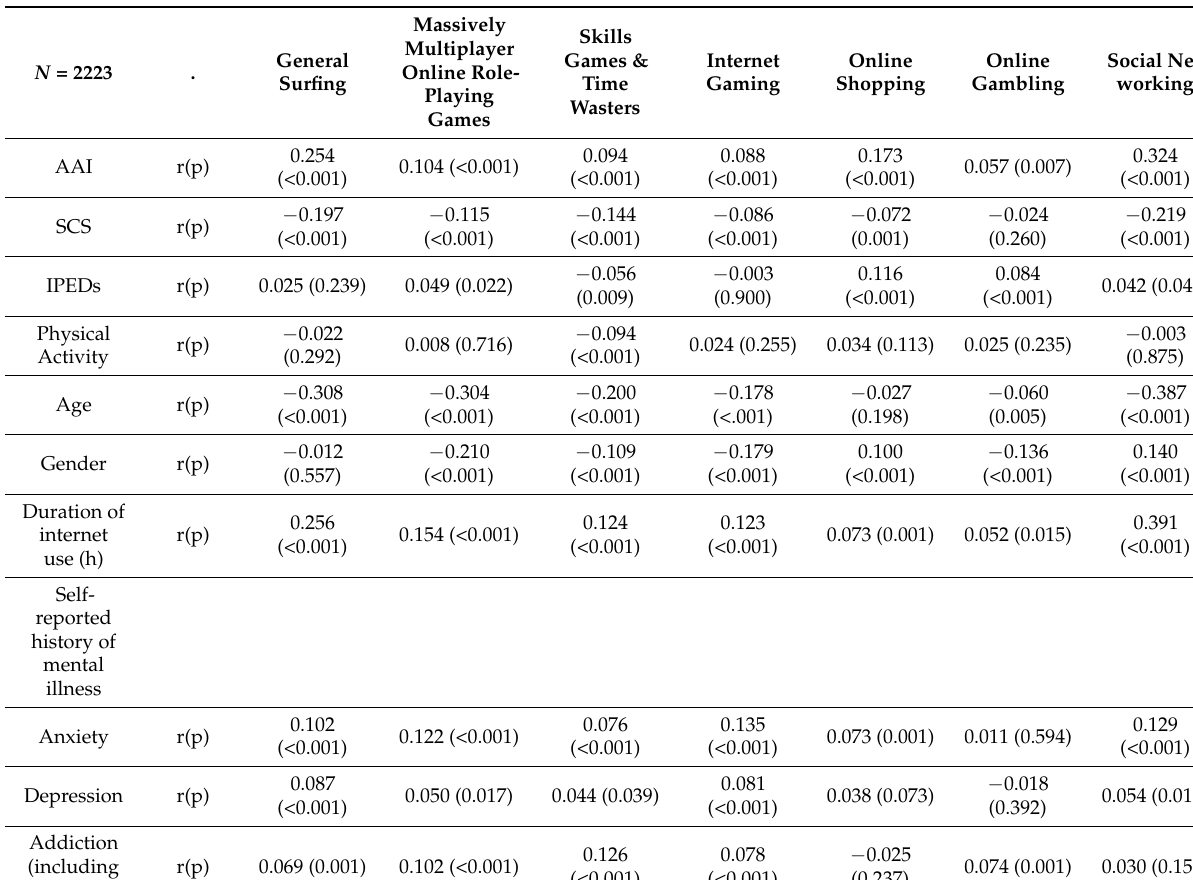
Table 2. Spearman correlation between self-reported internet activities and demographic, clinical, and psychological characteristics.